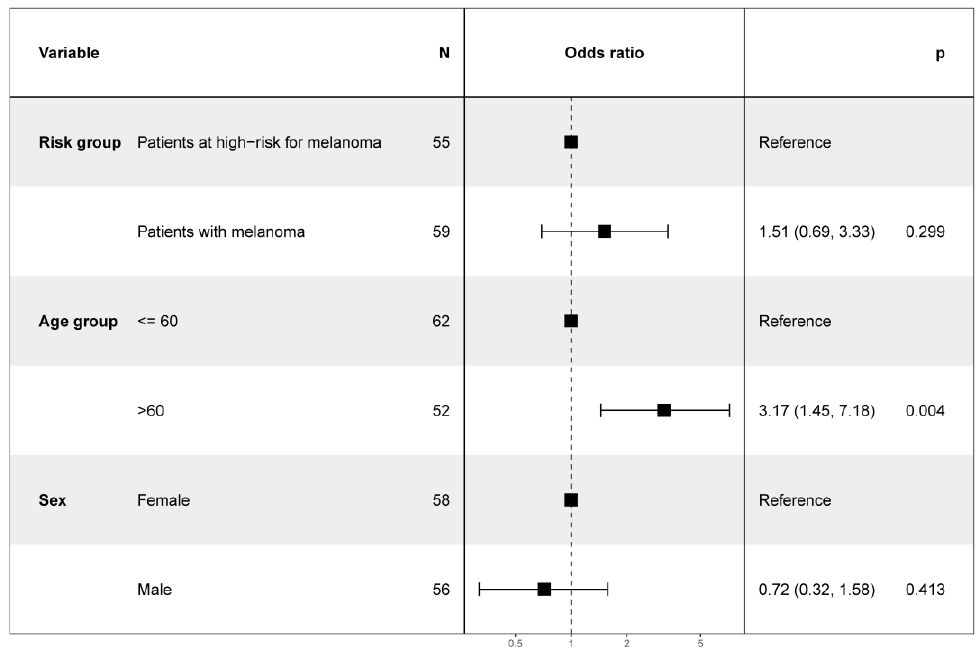
Figure 7. Odds ratio for variables influencing the trustworthiness of smartphones’ risk assessment in melanoma detection.